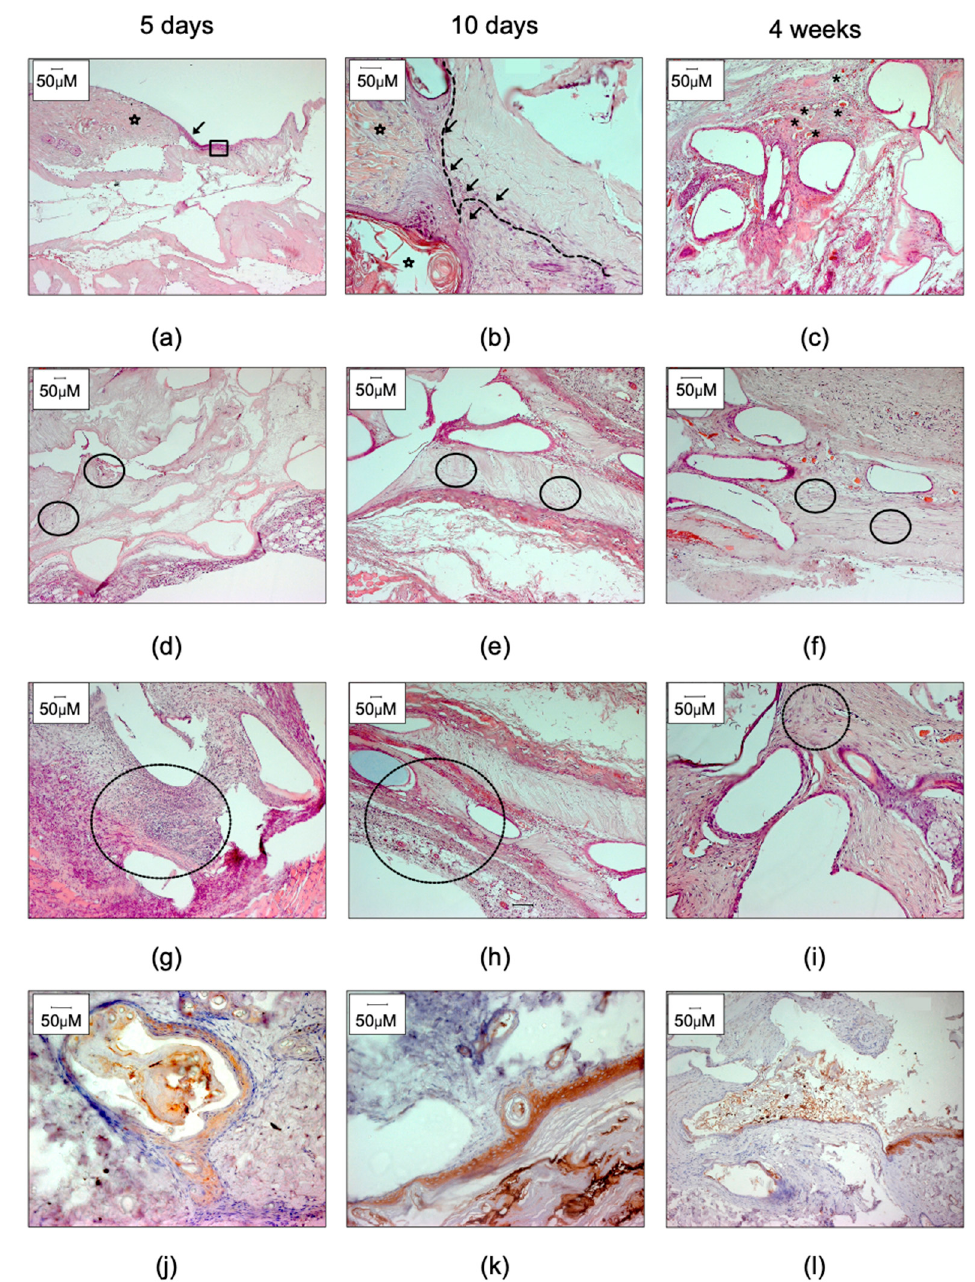
Figure 4. Histological images demonstrating the interactions between the 3D PC constructs and surrounding native tissue at different time points. ( a ) H&E staining at day 5, epithelial cells (arrow) were observed from the edge of the minced tissue (star) to the collagen parts of the scaffolds (square). ( b ) Neo-epithelialization was also observed 10 days after transplantation, and single-layer keratinocytes were visualized in clusters near the minced tissues (arrows and dotted line). ( c ) At 4 weeks, minced particles were hard to distinguish from the surrounding tissue, and regions with high content of new vessels were identified (asterisk). ( d – f ) Fibroblast-like cells and inflammatory cells (circles) were identified within the collagen parts of the 3D PCscaffolds. ( g – i ) The presence of inflammatory cells decreased with time (circles) in the 3D PC scaffolds. ( j – l ) Stratified squamous epithelium originated from grafted minced particles. H&E ( a – i ) and pan-cytokeratin immunostaining ( j – l ).